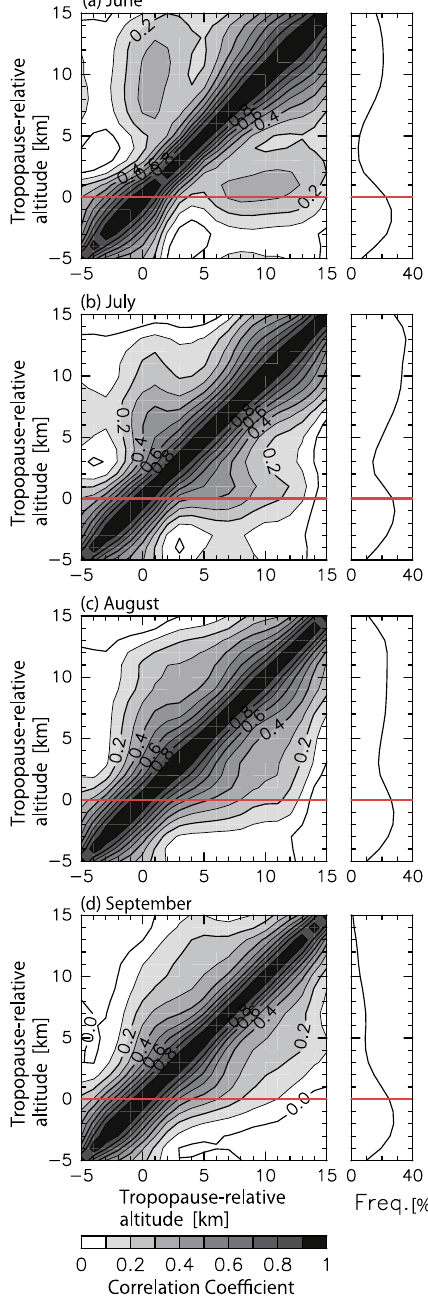
Fig. 5. Correlation coefficients between PSC/UC frequencies as functions of tropopause-relative altitude for June through Septem- ber from 2007 to 2011 (left). The correlation coefficients greater than approximately 0.16 are statistically meaningful at a signifi- cance level of 99%. Red curves indicate z TP = 0. The right panel shows PSC/UC frequency as a function of altitude (%).